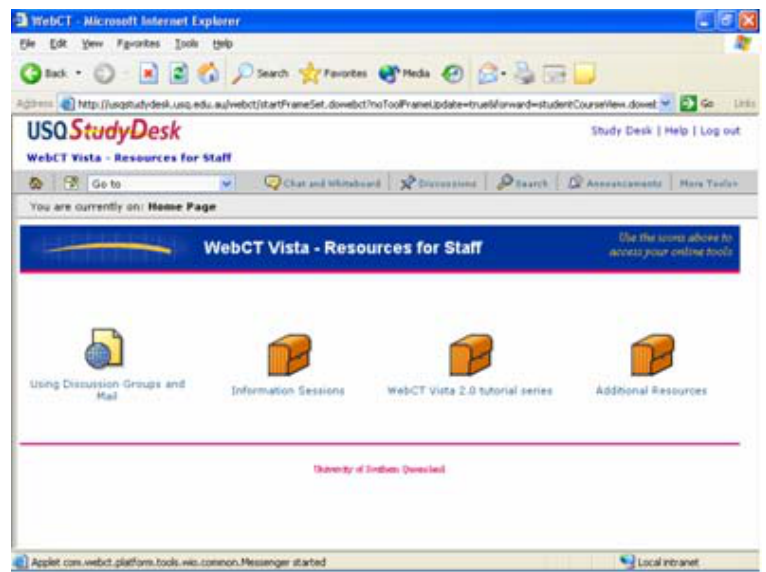
Figure 7. USQStudyDesk